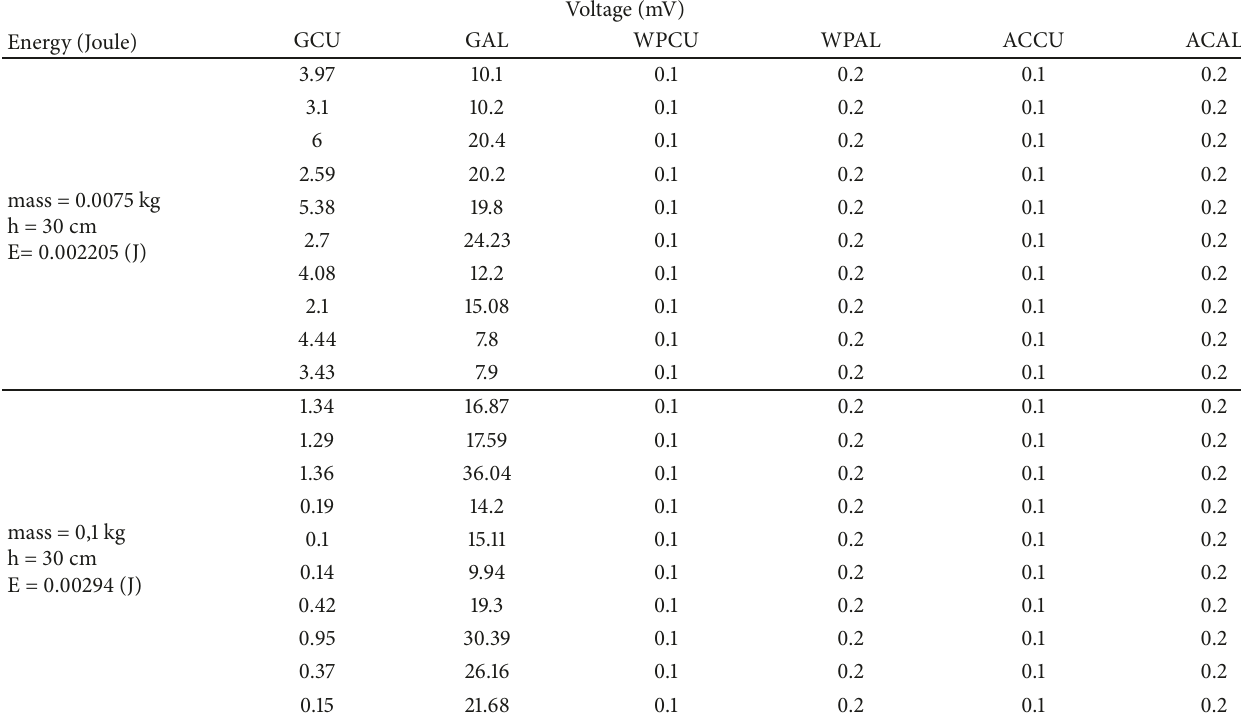
Table 3: Response voltage of